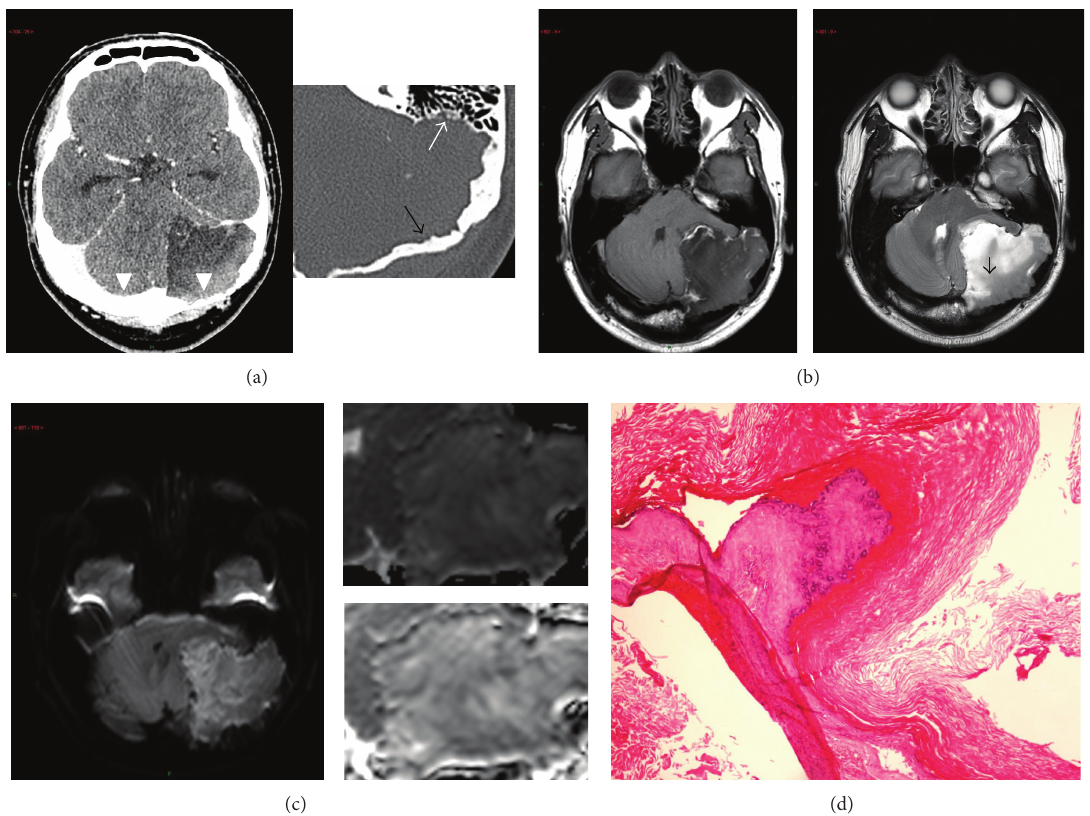
Figure2:(a)PlainCTbrain(left)andmagnifiedbonewindow(right)showanirregular,infiltrativemassintheleftposteriorcranialfossawith invasion into the cerebellum, calvarium (black arrow), and mastoid antrum (white arrow). The transverse sinus (white arrowhead) has also been invaded (compared to the normal transverse sinus on the right). No appreciable contrast enhancement is identified after IV contrast (not shown). Note the lack of perifocal oedema despite the aforementioned aggressive features. (b) T1-weighted (left) and T2-weighted (right) MRI images of the epidermoid cyst show the typical T1-hypo- and T2-hyperintense signal of an epidermoid cyst in the more anterior component. Heterogeneous signal intensity is noted in the most posterolateral component (black arrow). There is no perilesional oedema or appreciable contrast enhancement after IV gadolinium (not shown). (c) DWI with 𝑏 factor 1000 (left panel), masked ADC (right upper), and unmasked ADC (right lower image) demonstrate no significant restricted diffusion, as evident by the grossly isointense signal seen in the DWI and raw unmasked ADC map. (d) H&E section ( × 100 magnification) of the postsurgical specimen shows thick cyst wall of keratinizing squamous epithelium and amorphous keratin. Findings are compatible with an epidermoid